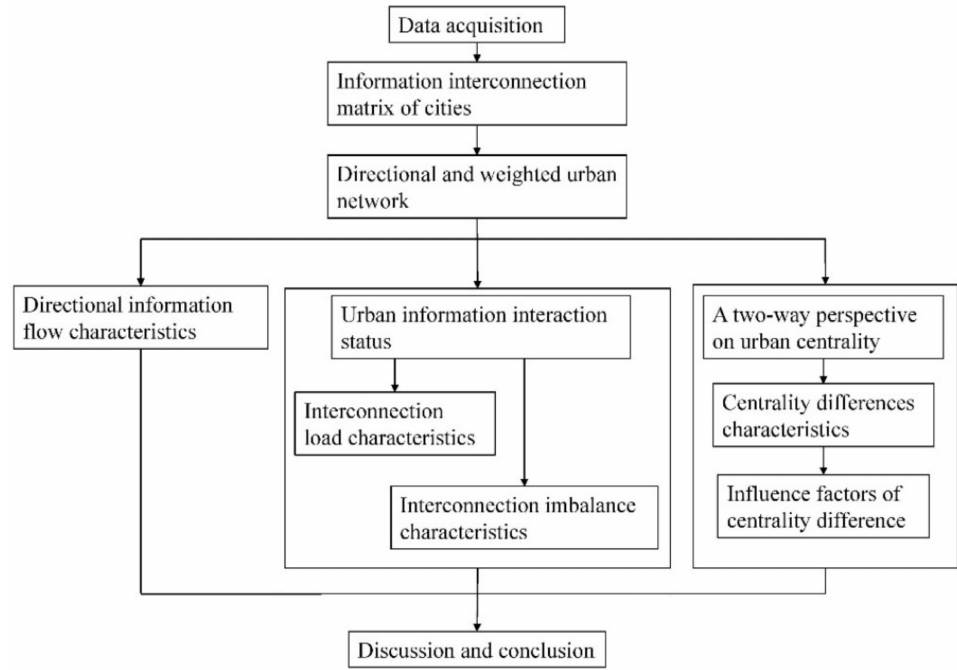
Figure 2. Logical framework